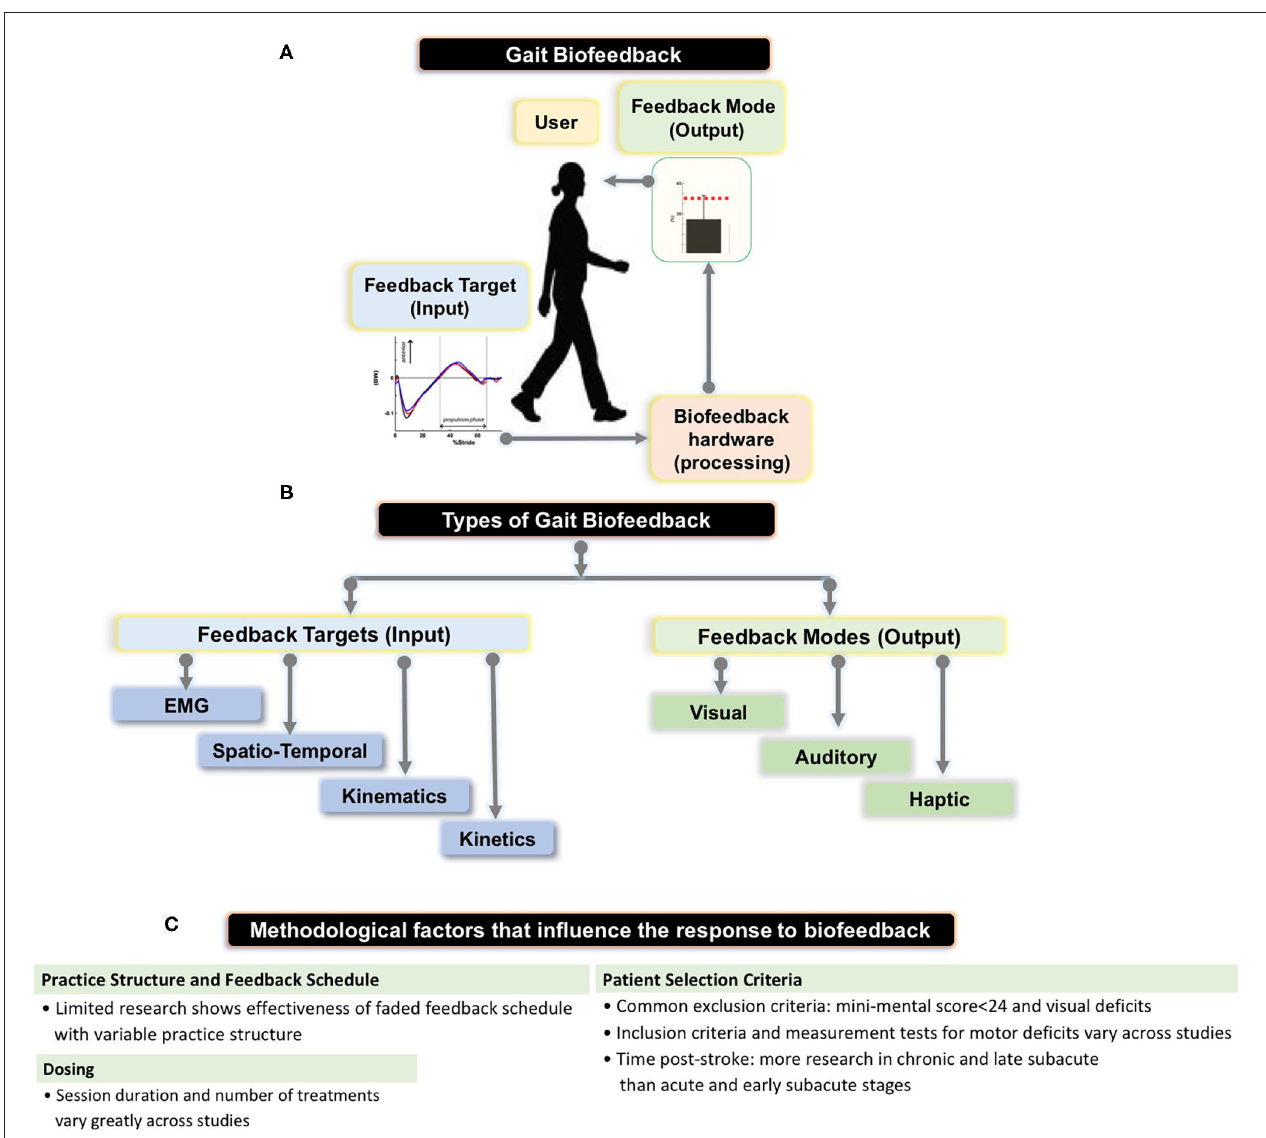
FIGURE 1 | (A) Schematic showing the setup for gait biofeedback, where a targeted gait parameter (e.g., anterior-posterior ground reaction force or electromyographic (EMG) activation) is measured, processed, and real-time, accurate information about the ongoing gait parameter is provided to the user via a feedback mode (e.g., audio-visual interface). (B) The flowchart shows types of feedback targets—EMG, spatio-temporal (e.g., step length, cadence), kinematic (e.g., joint angles), kinetic (e.g., ankle moment) as well as different feedback modes (e.g., visual, audio, haptic) that we summarize in our review, and provided by Stanton et al. (C) Summary of methodological parameters that we identified as factors influencing previous research results on biofeedback targeting stroke gait